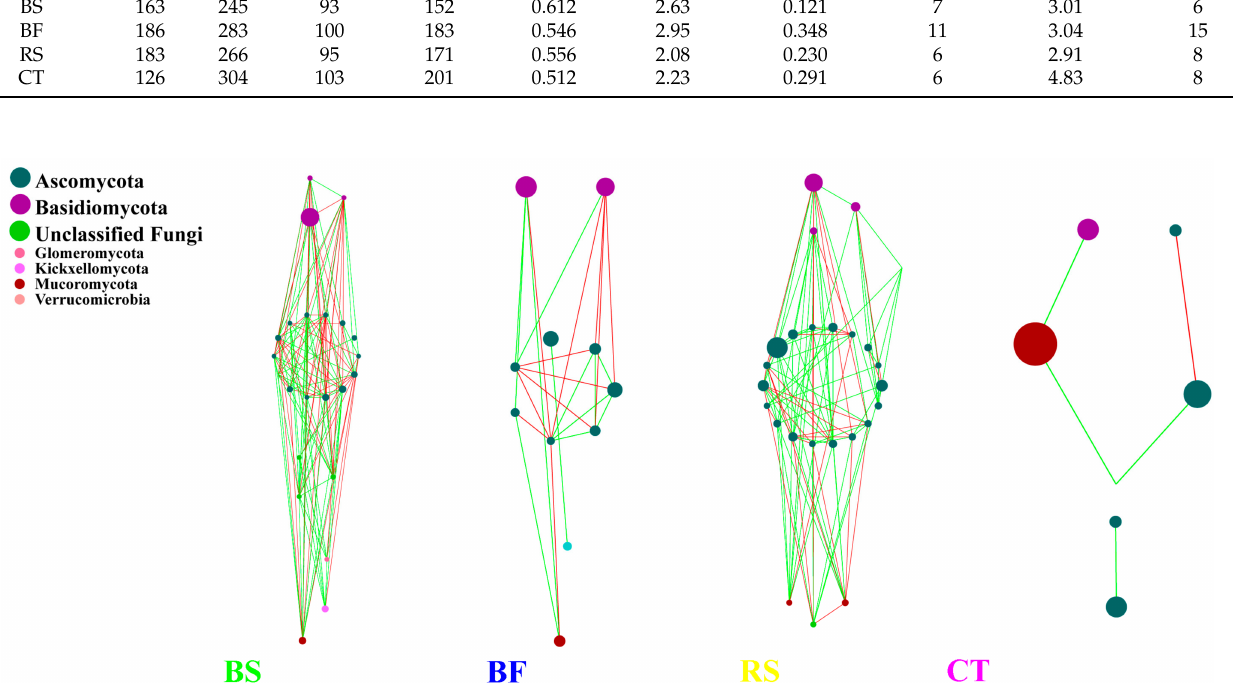
Table 5. Parameters of interaction networks of bacterial communities under different soil and water conservation measures. Soil Conservation